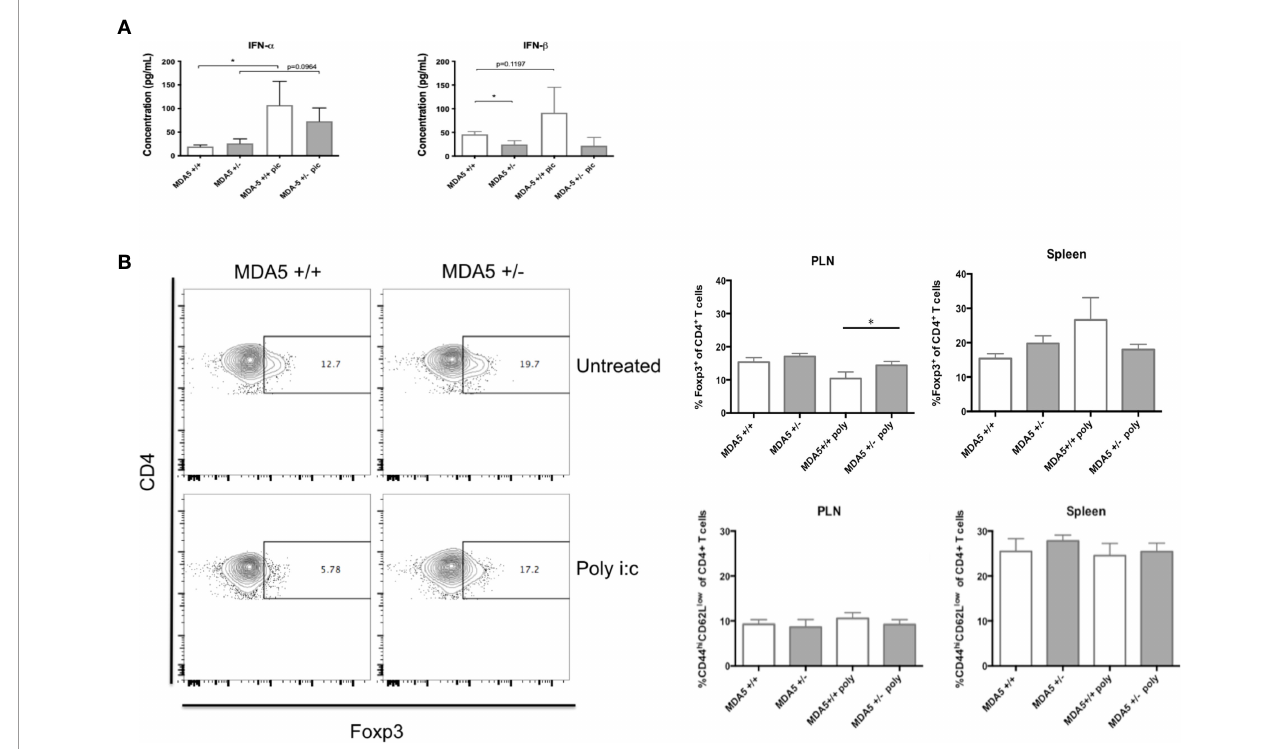
FIGURE 4 | Systemic IFN-I levels, regulatory and effector CD4 + T cell responses in MDA5 +/- and MDA5 +/+ mice after poly I:C stimulation and CB4 infection. (A) IFN- a / b In fl ammatory cytokine concentrations (pg/mL) were measured from MDA5 +/- (n = 7) and MDA5 +/+ (n = 7) mice sera at day 7 post-infection by ELISA. (B) Regulatory T cells (Foxp3 + CD4 + ) and effector T cells (CD44 hi CD62 low CD4 + and IFN g -producing CD4 + ) were isolated from the pancreatic lymph nodes (PLNs) and spleens of poly I:C treated and untreated MDA5 +/- (n = 5) and MDA5 +/+ (n = 5) mice at day 7 post CB4-infection and were stained with classical activation and maturation marker antibodies for FACS analysis. Results are shown as mean ± SEM of a representative from three independent experiments. GraphPad Prism 6.0 software (GraphPad, San Diego, CA) using the Student t test (two-tailed distribution) and a P value < 0.05 determined statistical signi fi cance *p <